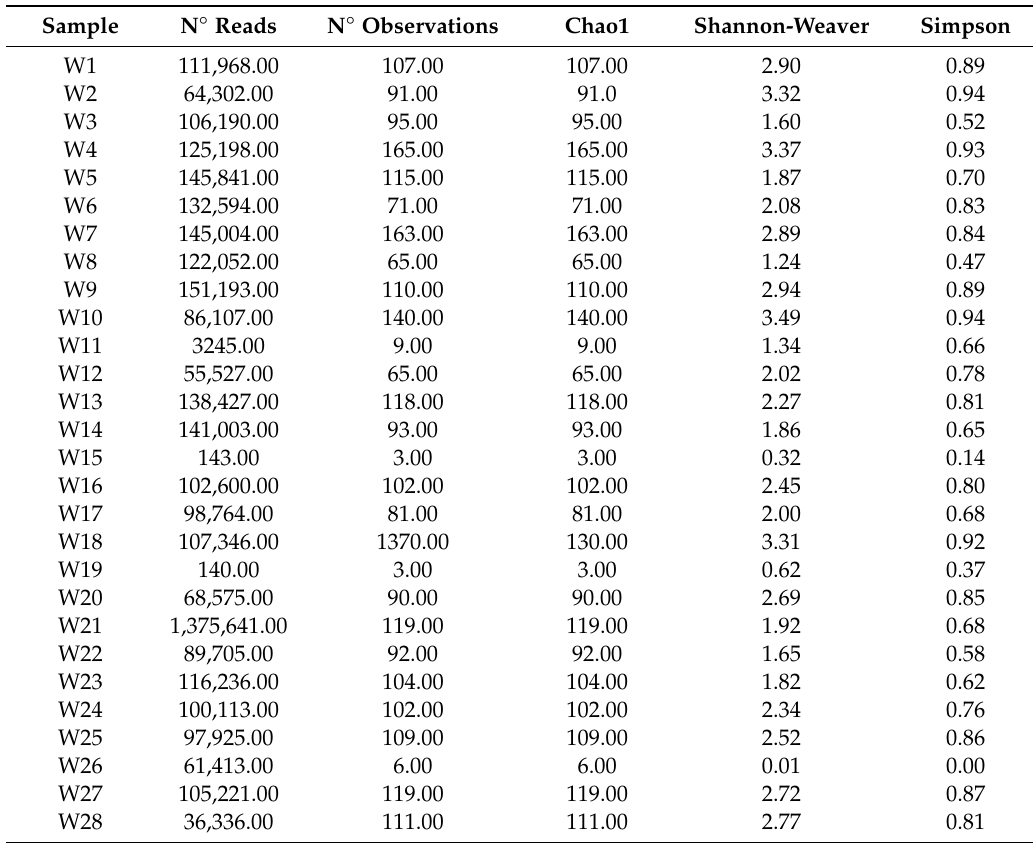
Table 1. N ◦ of reads and alpha diversity indexes at genus level of breast milk samples at di ff erent weeks (W) of the sampling